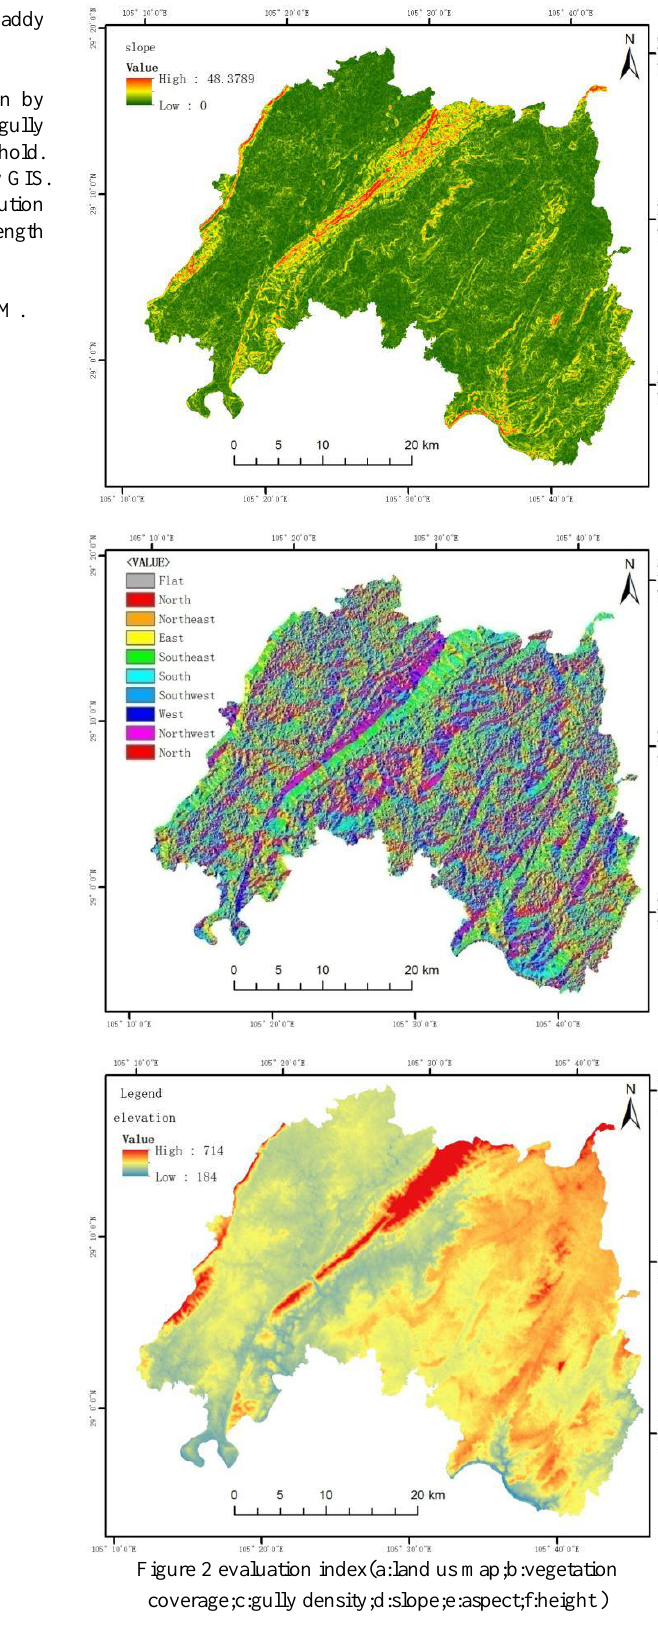
Figure 2 evaluation index(a:land us map;b:vegetation coverage;c:gully density;d:slope;e:aspect;f:height